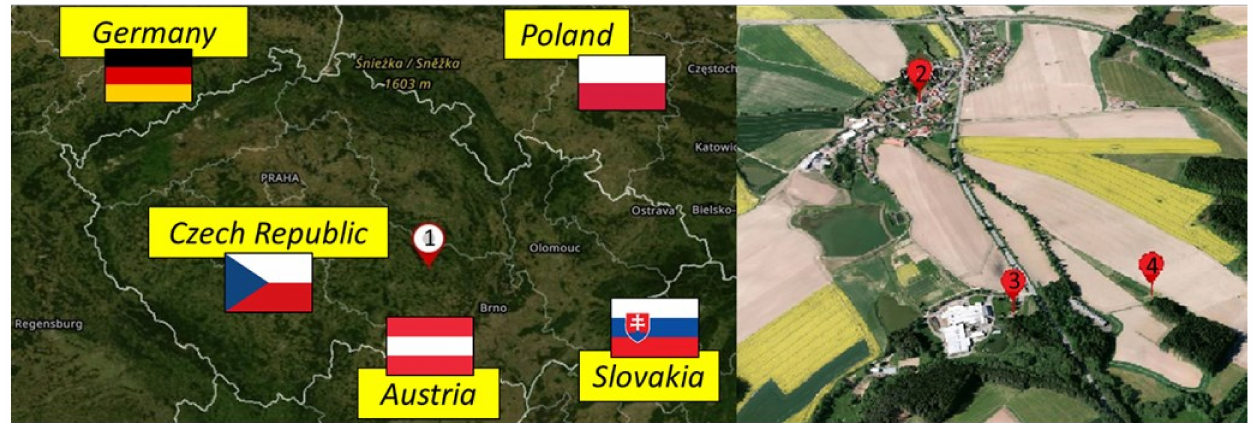
Figure 1. Location of the Vat í n Experimental Station; (1) position of the station in the Czech Republic; (2) village of Vat í n; (3) rear of the station; (4) experimental plot.